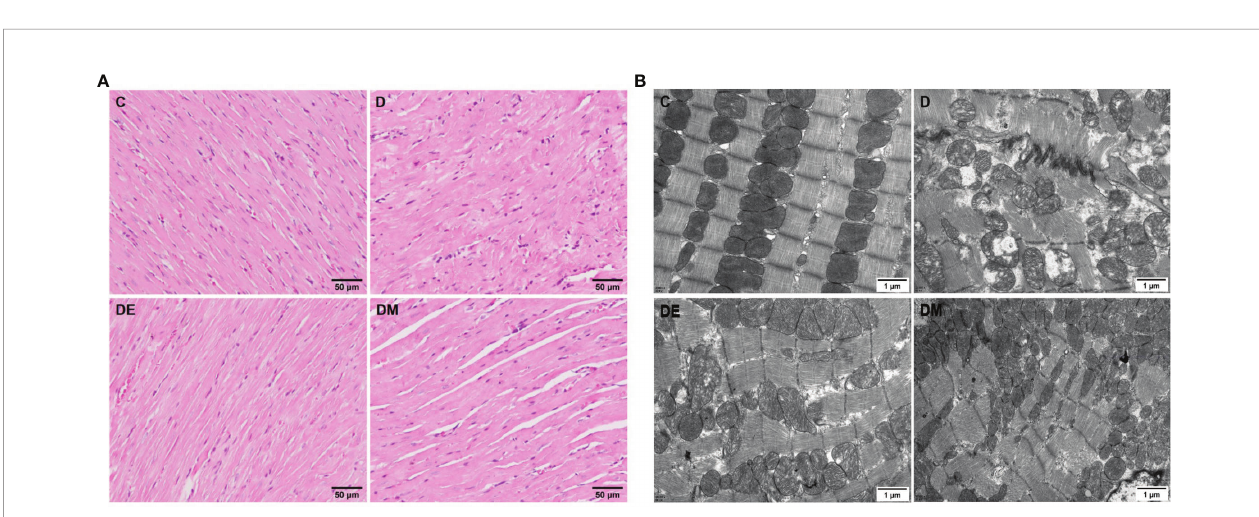
FIGURE 2 | Myocardial morphological changes after 8 weeks of aerobic exercise and MOTS-c treatment. (A) HE staining images of left ventricular sections. (B) Cardiac ultra-structure detected using transmission electron micrograph. C (control), D (diabetic), DE (diabetic+ exercise), DM (diabetic + MOTS-c).